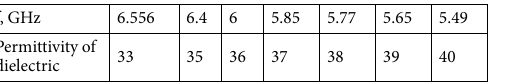
Table 1. One can conclude that the permittivity located close to 35–35.5 well corresponds to our experimental anapole response frequency 6.33 GHz. Thus, the main discrepancy reason is attributed to the permittivity of